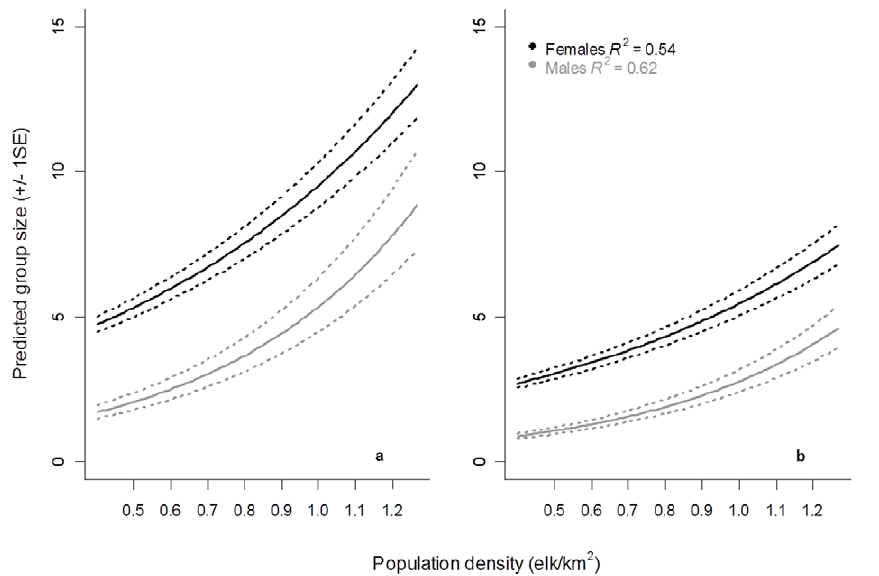
Figure 2. Predicted change in unadjusted group size for female and male elk in Riding Mountain National Park ( 2002–2005 and 2007–2009 ) ; here the dichotomy between density-dependent response in group size for females and males is pronounced. These models also control for seasonal sight-ability bias due to canopy cover (a) October – March, (b) April – September.